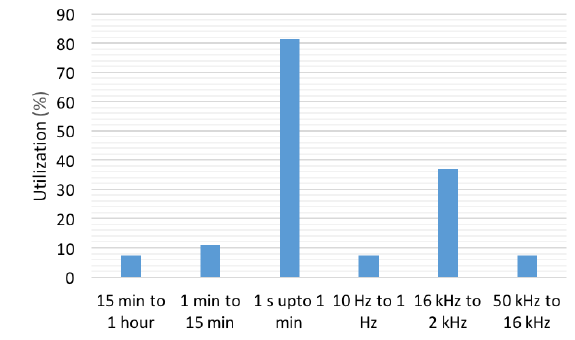
Figure 8. Sampling frequency used by e-monitors.